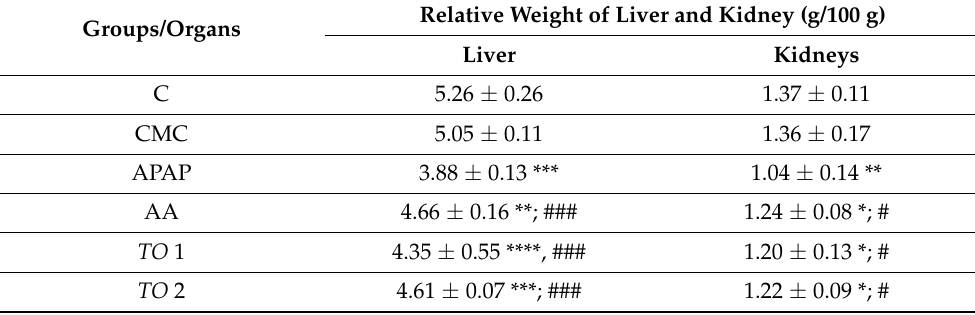
Table 5. Relative organ weight to body weight of Swiss albino mice receiving Taraxacum officinale essential oil for 14